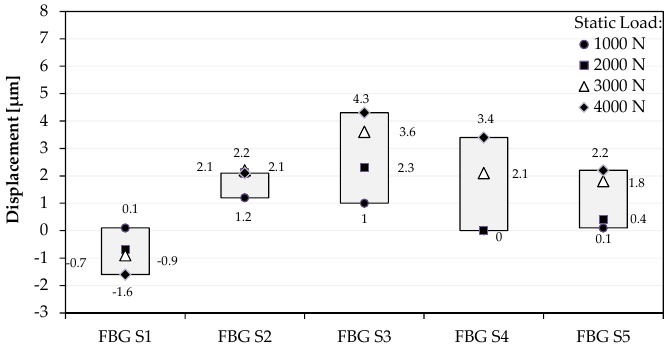
Figure 6. The displacements ( µ m) measured by the FBG sensors applying a set of static forces. The position of each FBG sensor is critical for detecting the stress measured on the MT frame.